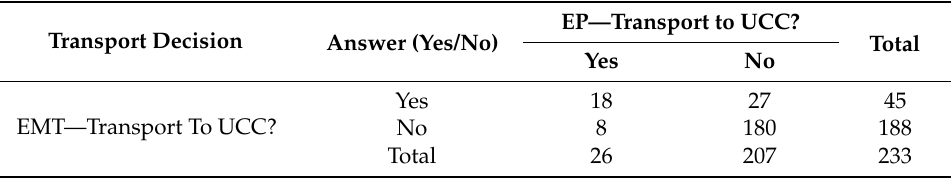
Table 1. Summary of survey diversion question data.